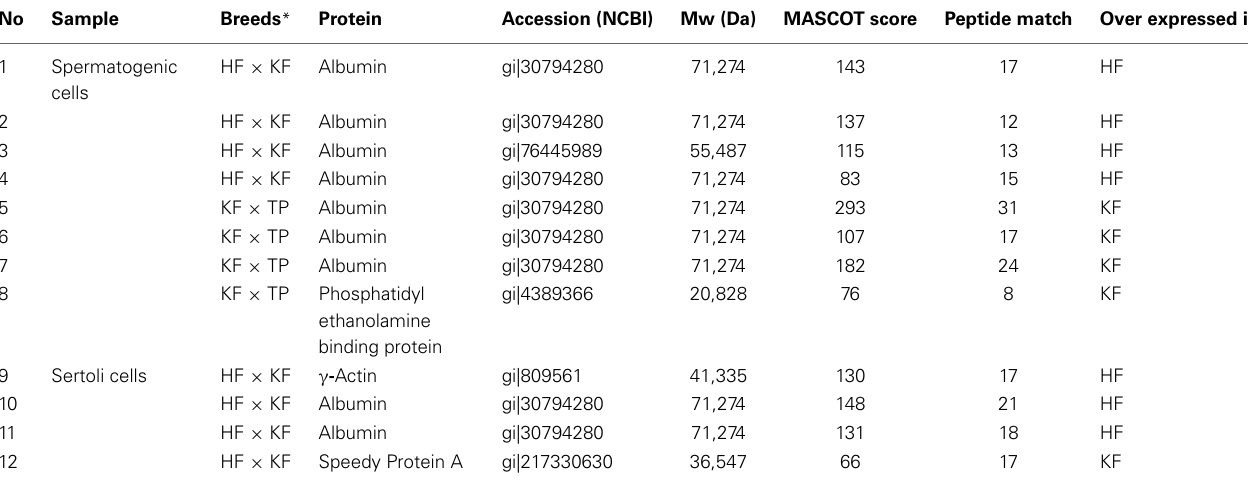
Table 4 | Details of differentially expressed proteins identified through MALDI-TOF/MS. No Sample